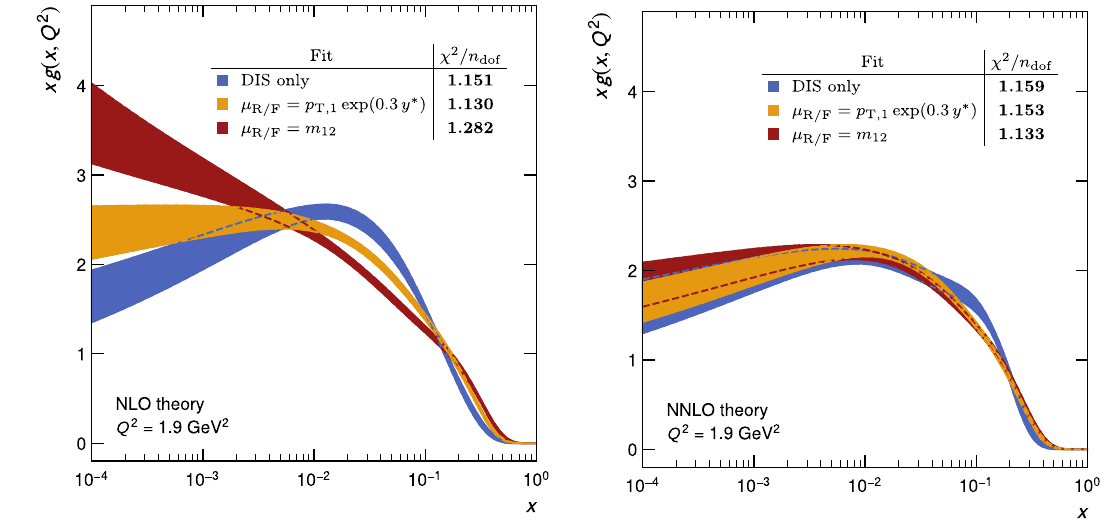
Fig. 9 The gluon PDF from fits to HERA DIS alone and with CMS dijet data at NLO (left) and NNLO (right) for two different central scale choices for dijet production: μ